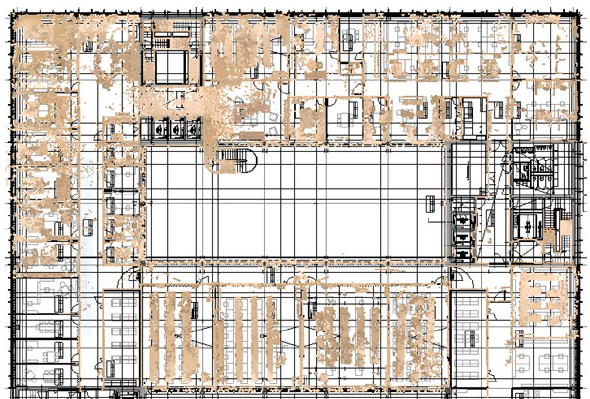
Figure 4. Overlapping horizontal section of the point cloud and